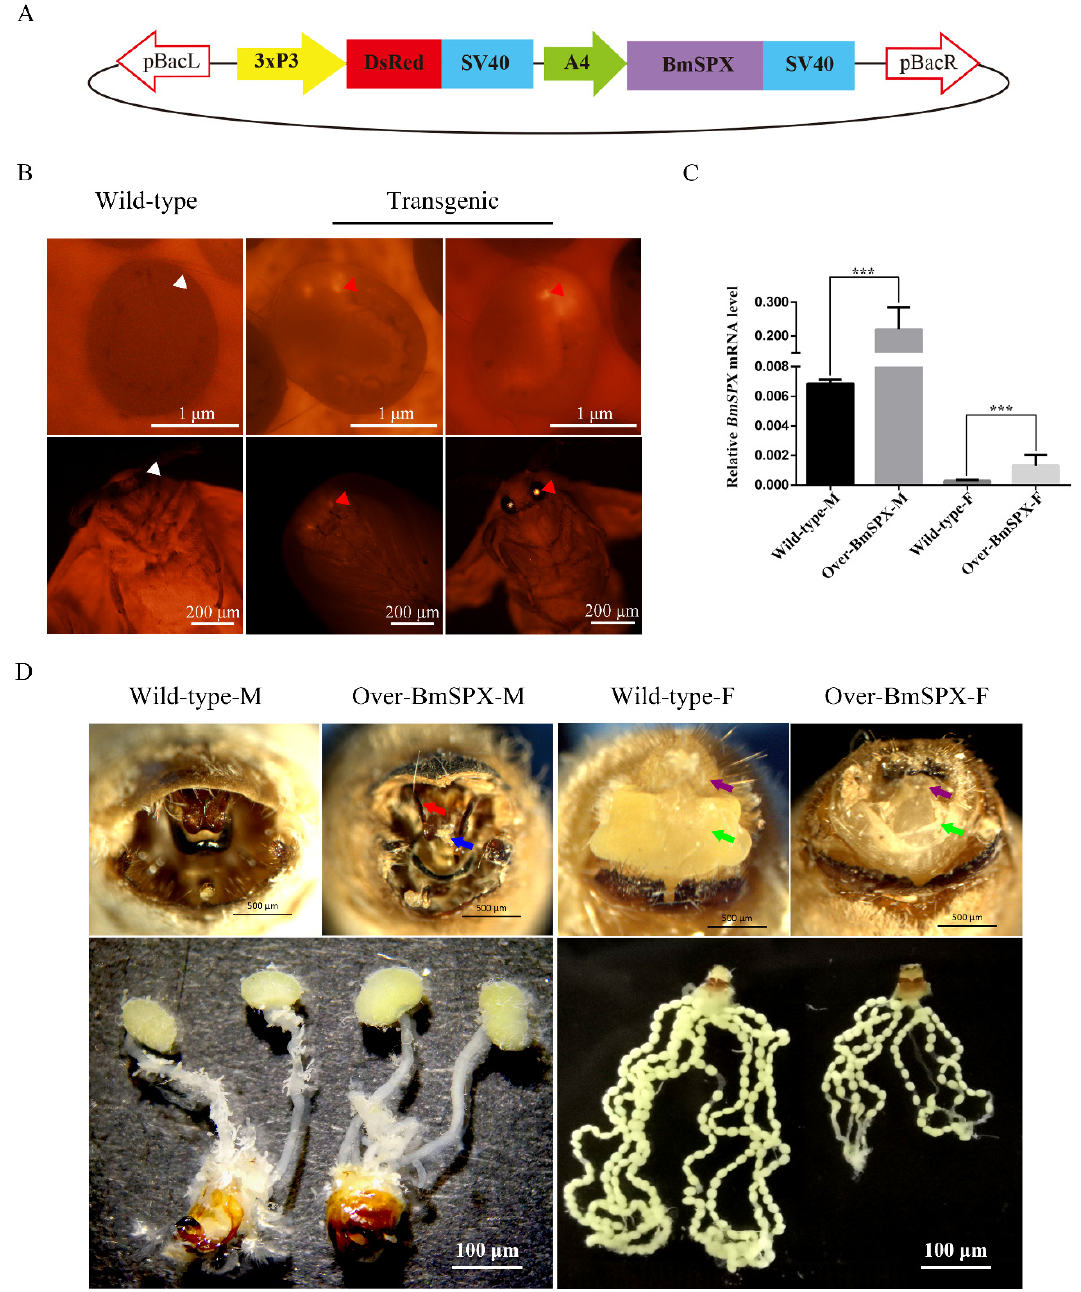
Figure 1. Establishment and phenotypic observation of Over-BmSPX transgenic strains. ( A ) Structure of piggyBac-BmSPX recombinant vector. 3xP3 and A4 promoters were used in the recombinant vector. The SV40 terminator was used to stop the transcription. pBacL and pBacR indicate the left and right terminal inverted repeats. 3xP3 indicate a hyperactive promoter containing three binding sites for Pax-6 homodimers in front of a TATA box. DsRed, Discosoma sp. Red Fluorescent Protein. SV40, Terminator of Simian virus 40 . A4, Actin 4 promotor of B. mori . ( B ) The process of screening transgenic strains. The signal of DsRed in transgenic strain is indicated with red triangles. The positions without DsRed in Wild-type strain are indicated with white triangles. ( C ) Real-time PCR of BmSpx to confirm BmSpx over-expression. A value of p < 0.05 was considered to be statistically significant (* p < 0.05, ** p < 0.01, *** p < 0.001). ( D ) Phenotypic and gonad observations of Over-BmSPX strains. Wild-type-M and